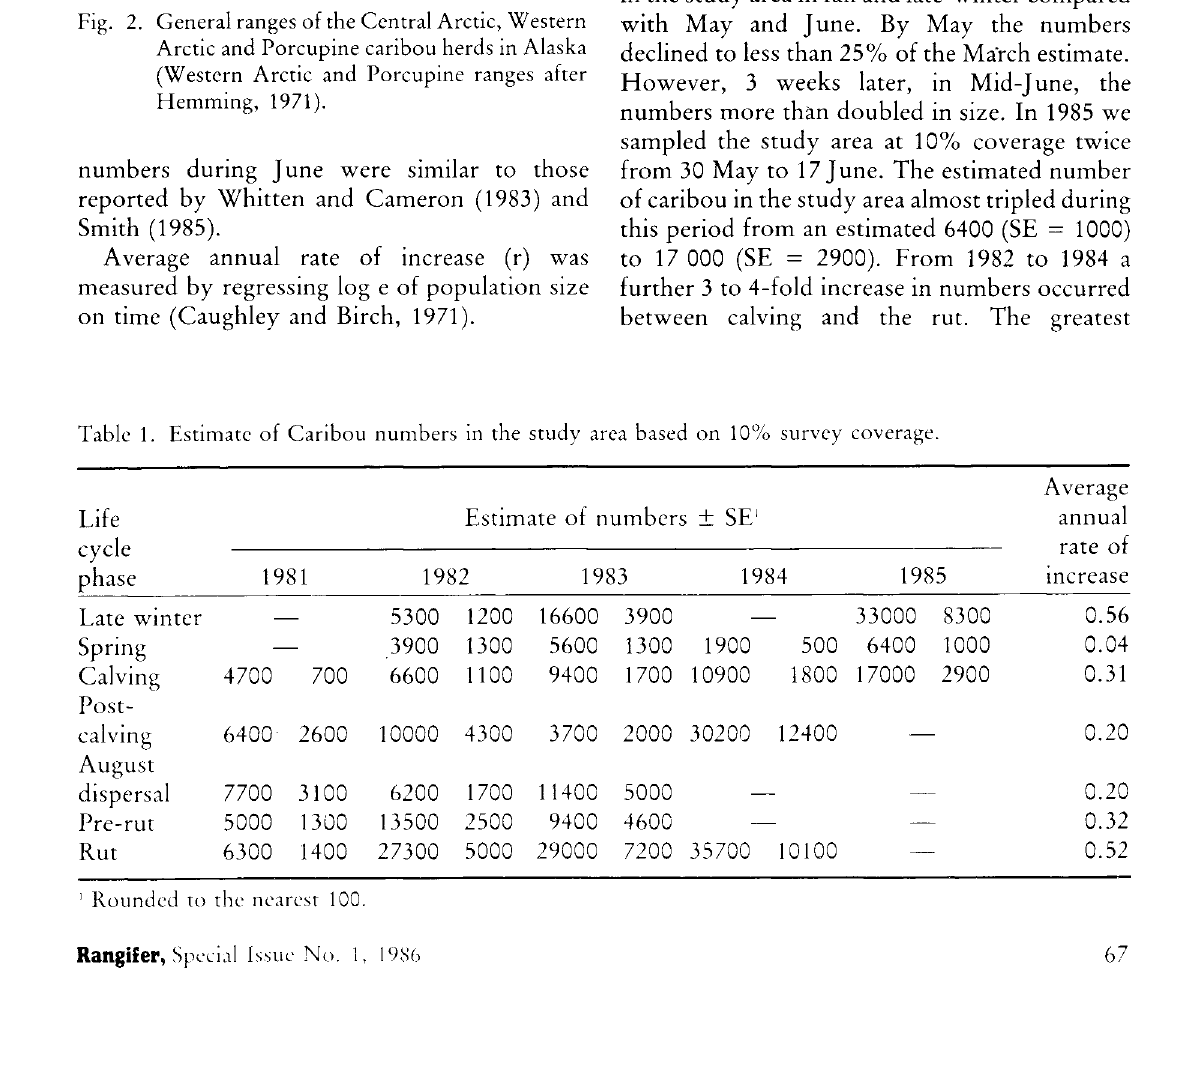
Fig. 2. General ranges of the Central Arctic, Western Arctic and Porcupine caribou herds in Alaska (Western Arctic and Porcupine ranges after Hemming, 1971). numbers during June were similar to those reported by Whitten and Cameron (1983) and Smith (1985). Average annual rate of increase (r) was measured by regressing log e of population size on time (Caughley and Birch, 1971).